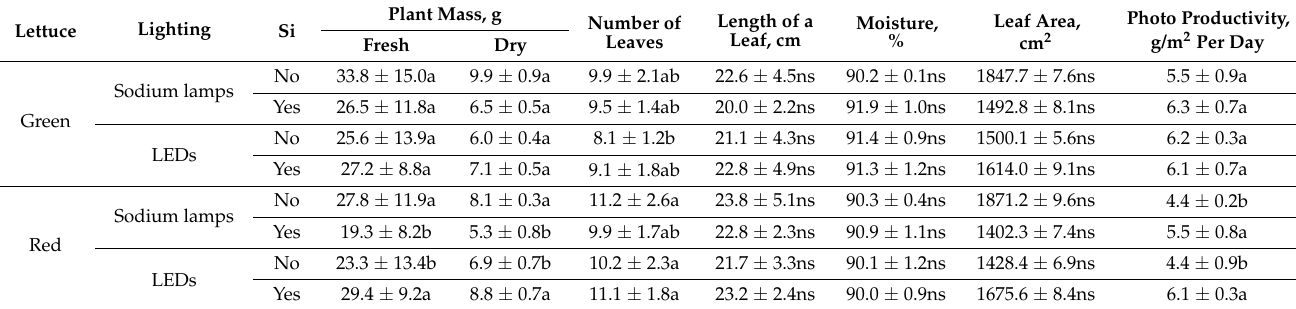
Table 3. Averaged biometric parameters of the aerial part of green and red lettuce ( Lactuca sativa L.) under the conditions of a regulated agroecosystem on the 30th day of cultivation. Values represent mean ± SE ( n = 12). The different letters indicate significant differences among treatments and ns means non-significant differences among treatments according to Duncan’s test ( p ≤